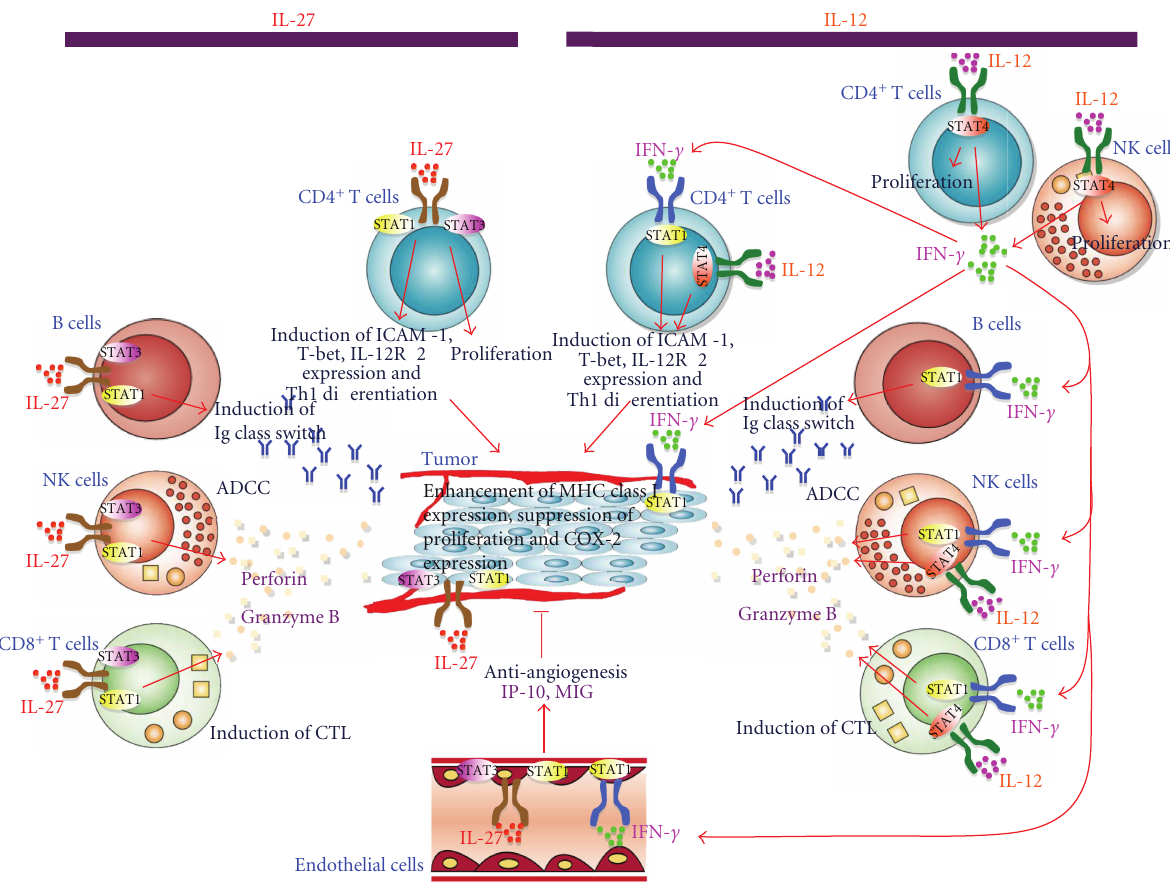
Figure 2: Di ff erences in the molecular mechanisms to induce antitumor e ff ects between IL-12 and IL-27. IL-27 utilizes several mechanisms to induce antitumor e ff ects depending on characteristics of individual tumors. Against highly immunogenic tumors expressing MHC class I, IL-27 exerts antitumor e ff ects by mainly CD8 + T cells. However, against poorly immunogenic tumors lacking expression of IL-27R, IL-27 has to use other mechanisms including NK cells and antiangiogenesis to exert its antitumor e ff ects. In contrast, IL-12 has a strong antitumor e ff ect through high production of IFN- γ by NK and T cells. This high IFN- γ production also causes systemic toxicities, which leads to limitation of the IL-12 therapy in clinical